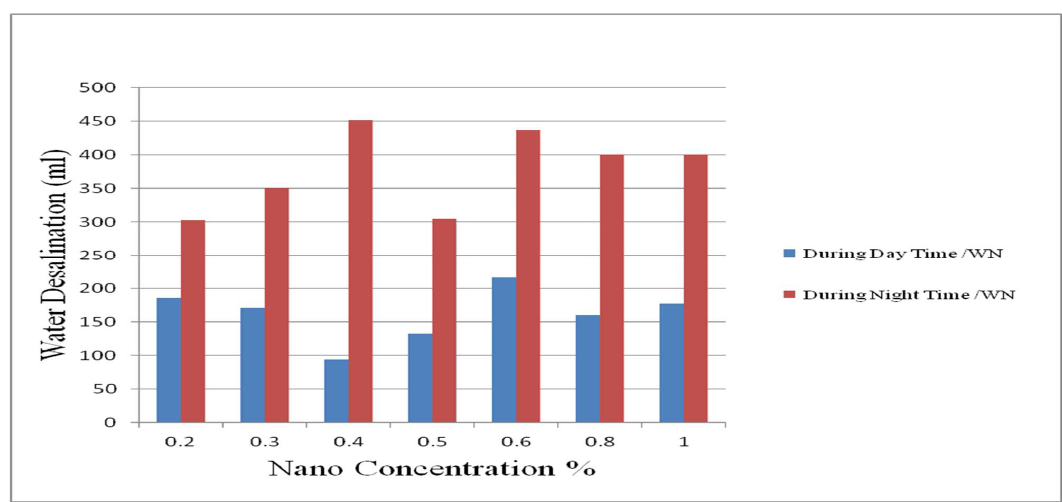
Figure 6. Hourly solar radiation and glass and water temperatures for 0.4% concentration.